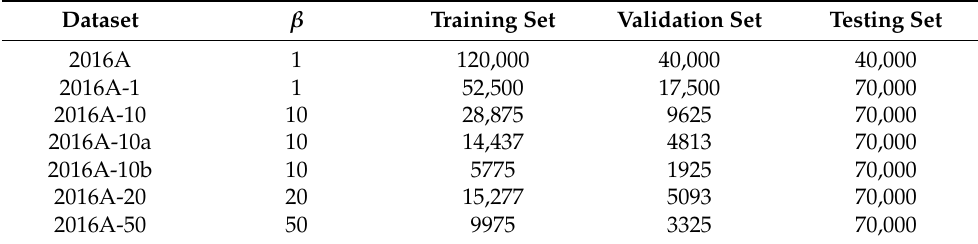
Table 1. Composition of individual datasets.